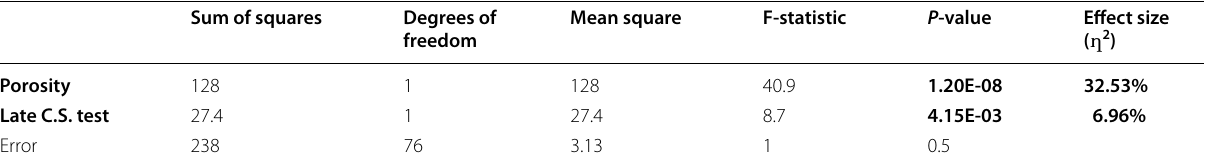
Table 4 ANOVA to explain changes in compressive strength among all specimens, segregated by early or late compressive strength test